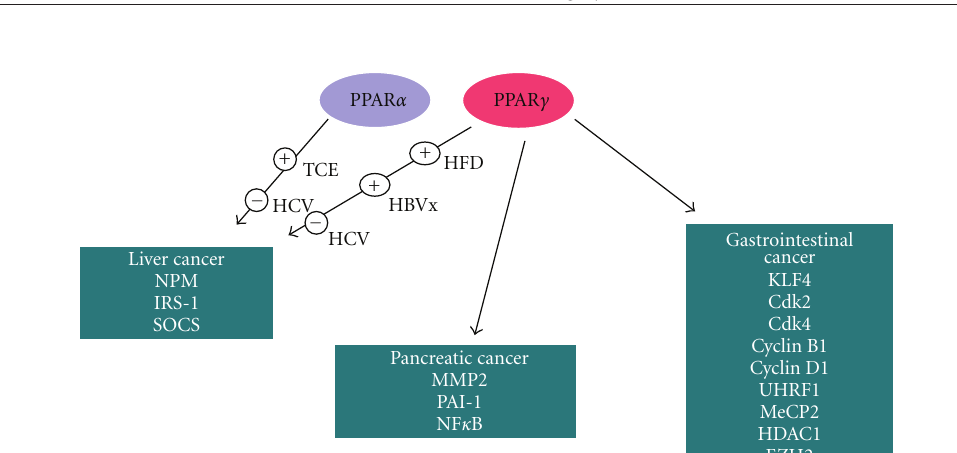
Figure 1: Schematic representation of the PPARs signaling operating in cancer. Krueppel-like factor 4 (KLF4); cyclin-dependent kinase (2, 4); cyclin B1, D1; ubiquitin-like, containing PHD and RING finger domains, 1; methyl CpG binding protein 2 (MeCP2); Histone deacetylase 1(HDAC1); histone-lysine N-methyltransferase (EZH2); matrix metallopeptidase 2 (MMP2); plasminogen activator inhibitor 1 (PAI-1) nuclear factor-kappaB (NF κ B); nucleophosmin (NPM); insulin receptor substrate 1 (IRS-1); suppressor of cytokine signal (SOCS). For further explanations, please refer to the